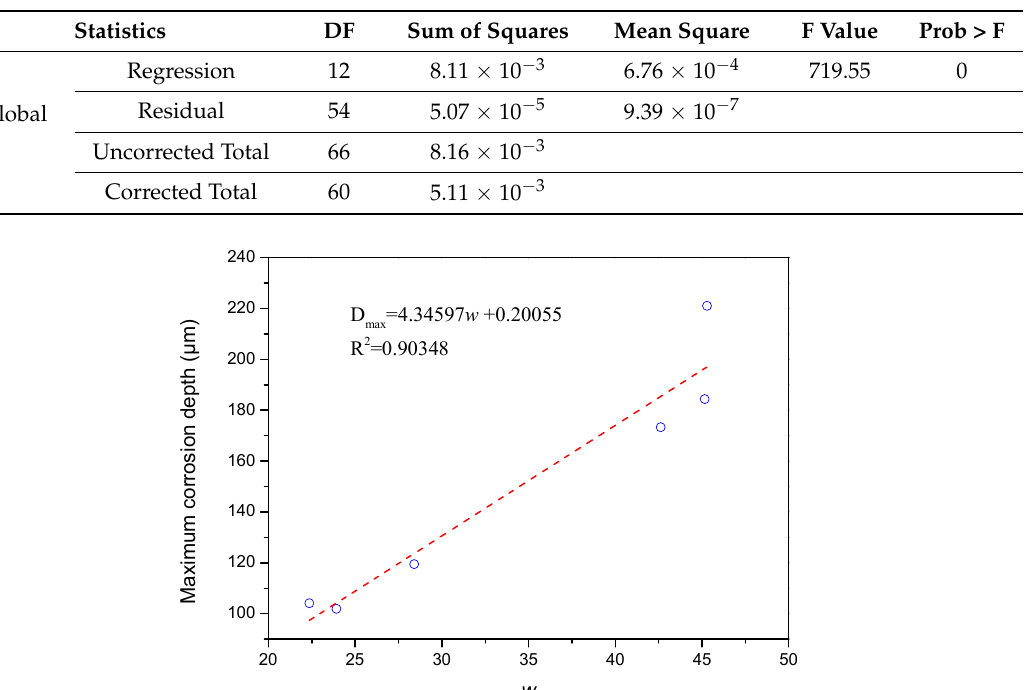
Table 5. Parameters for the Gaussian model fitting of corrosion depth distribution.